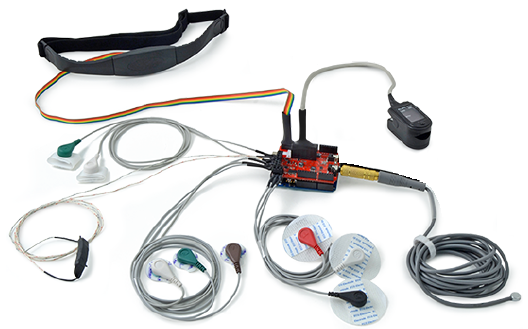
Figure 9. eHealth platform [12].